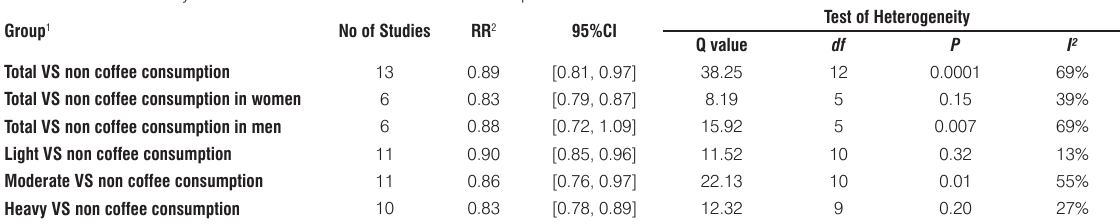
Table 2. Meta analysis results of Relative Risk of coffee